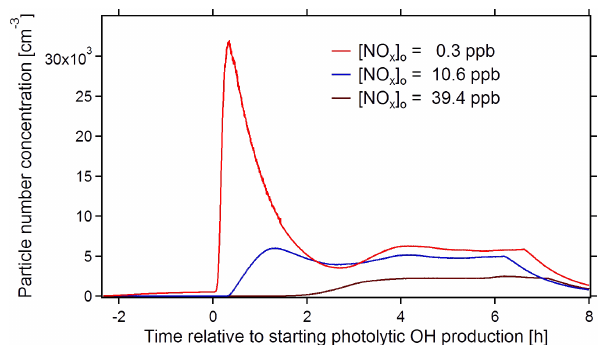
Fig. 3. Temporal shape of particle number concentrations for differ- ent [NO x ] 0 . The sharp decrease of particle number concentration observed 6–8h after inducing particle formation by OH production was caused by switching off the OH production and subsequent par- ticle formation. striking observations were made. The first was a decrease of maximum particle number concentration with increasing NO x indicating a decrease of J 7 . The second was a delay be- tween the start of photolytic OH production and the onset of NPF. During long lag times [NO x ], [O 3 ] and [OH] systemat- ically changed with time. While [NO x ] decreased, [O 3 ] and [OH] increased (see Fig.